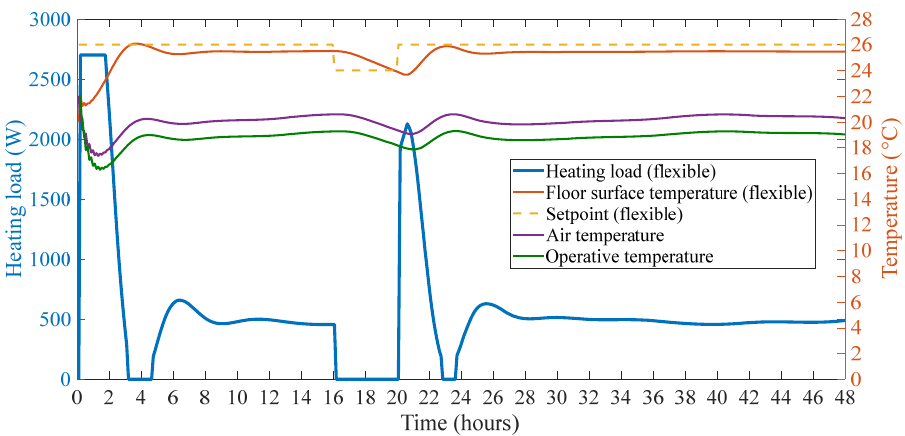
Figure 9. Zone air and operative temperatures profiles with surface temperature control strategy. The BEFI D for this downward flexibility event is 457 W or BEFI D = 50 W/m 2 . For the next day, the morning peak period of 6–9 a.m. (hours 30–33 in the figure), a predictive strategy is considered to preheat the slab by increasing the setpoint to 28 ◦ C at night for 3 h